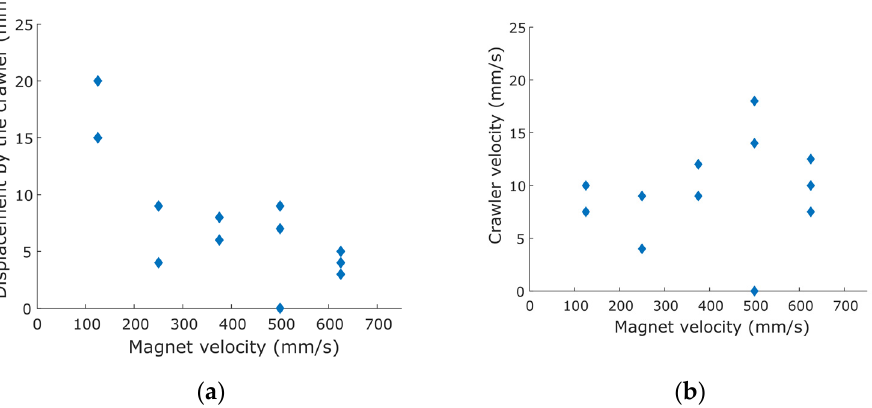
Figure 10. Scatter plot of ( a ) the displacement by the MAE crawler in one cycle against the average velocity of the magnet, and ( b ) crawler velocity against the average velocity of the magnet in vertical pipe in the case of peristaltic locomotion. Due to repeated data points, there are less than 3 observable data points for certain